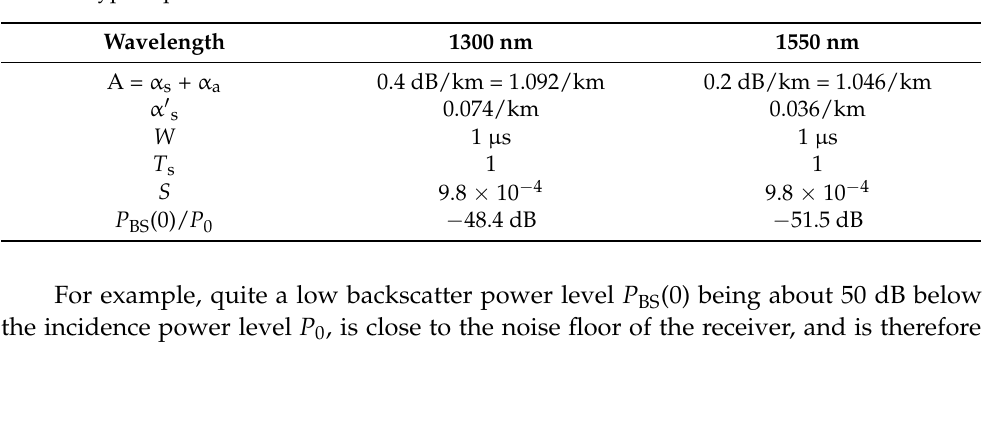
Table 1. Typical parameters’